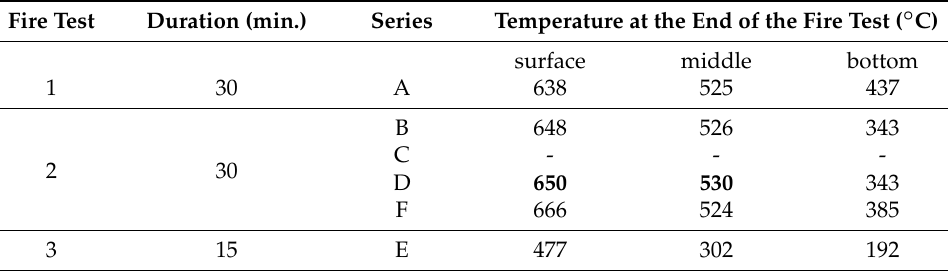
Table 3. Temperature measurements from fire tests 1, 2 and